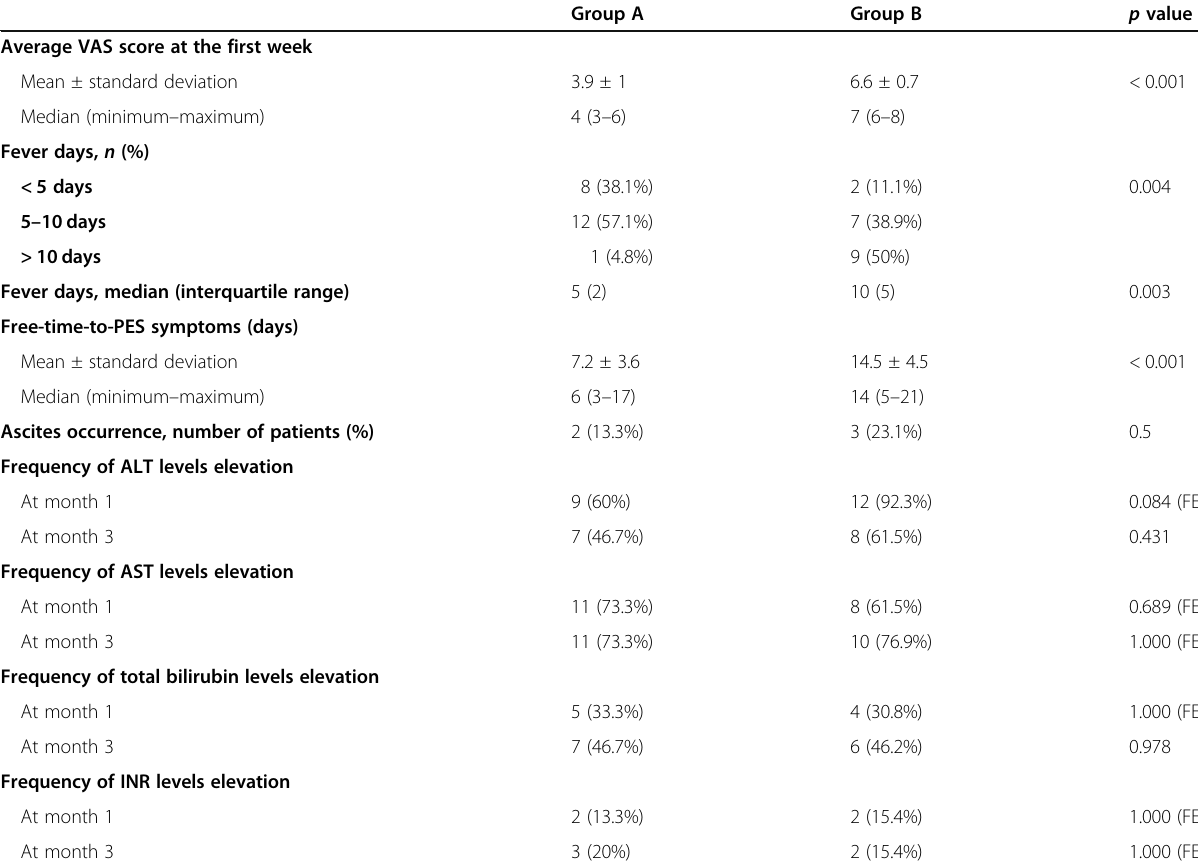
Table 2 Comparison between groups A and B according to clinical outcome and overall survival